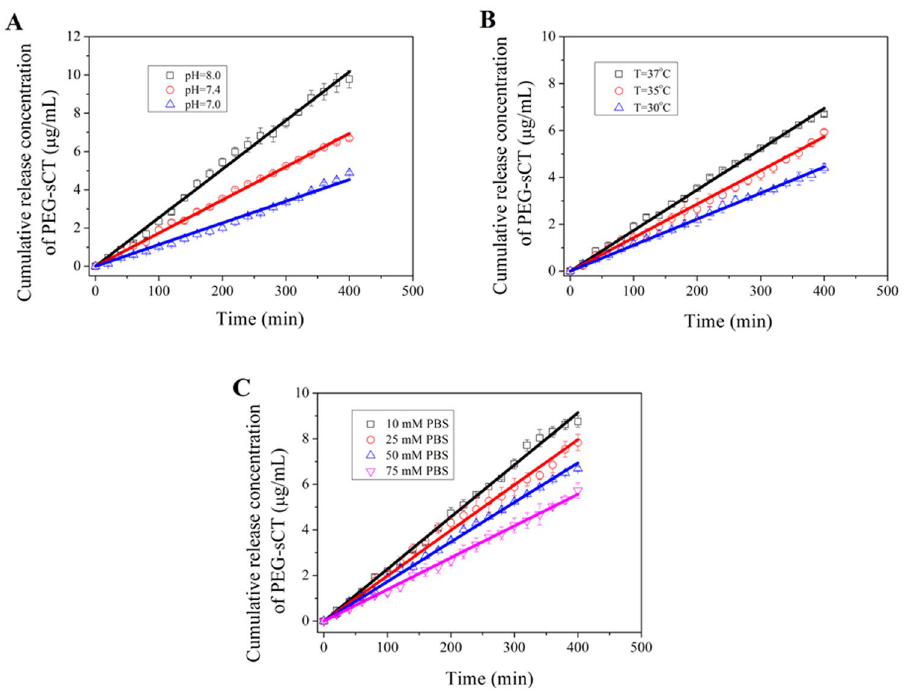
Figure 5. Release profiles of PEG-sCT from (PEG-sCT/TA) 6 films under various conditions: ( A ) in 50 mM phosphate buffer of various pH as indicated, T = 37 °C; ( B ) in 50 mM pH7.4 phosphate buffer at various temperatures; ( C ) in various concentration of phosphate buffer. pH = 7.4, T = 37